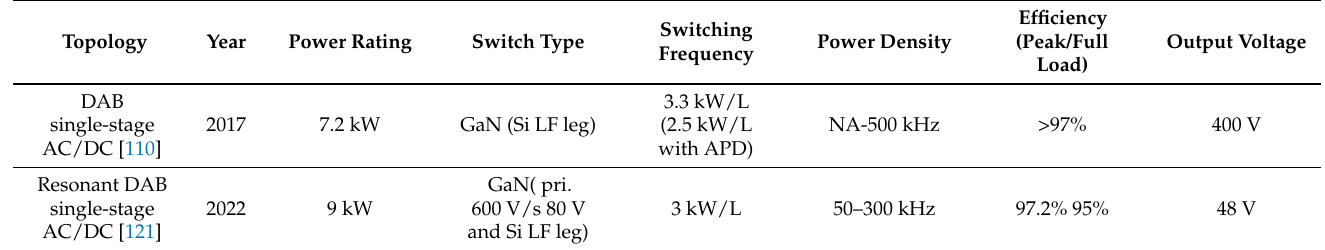
Table 6. Summary of GaN-based single-stage AC/DC converter topologies.